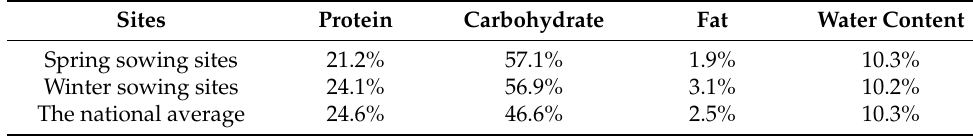
Table 2. Quality analysis of regional trial sites of Longwan No. 6 pea cultivars. Sites Protein Carbohydrate Fat Water Content Spring sowing sites 21.2% 57.1% 1.9% 10.3% Winter sowing sites 24.1% 56.9% 3.1% 10.2% The national average 24.6% 46.6% 2.5%